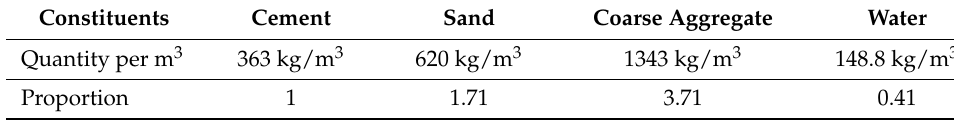
Table 3. Mix proportion of the control concrete.